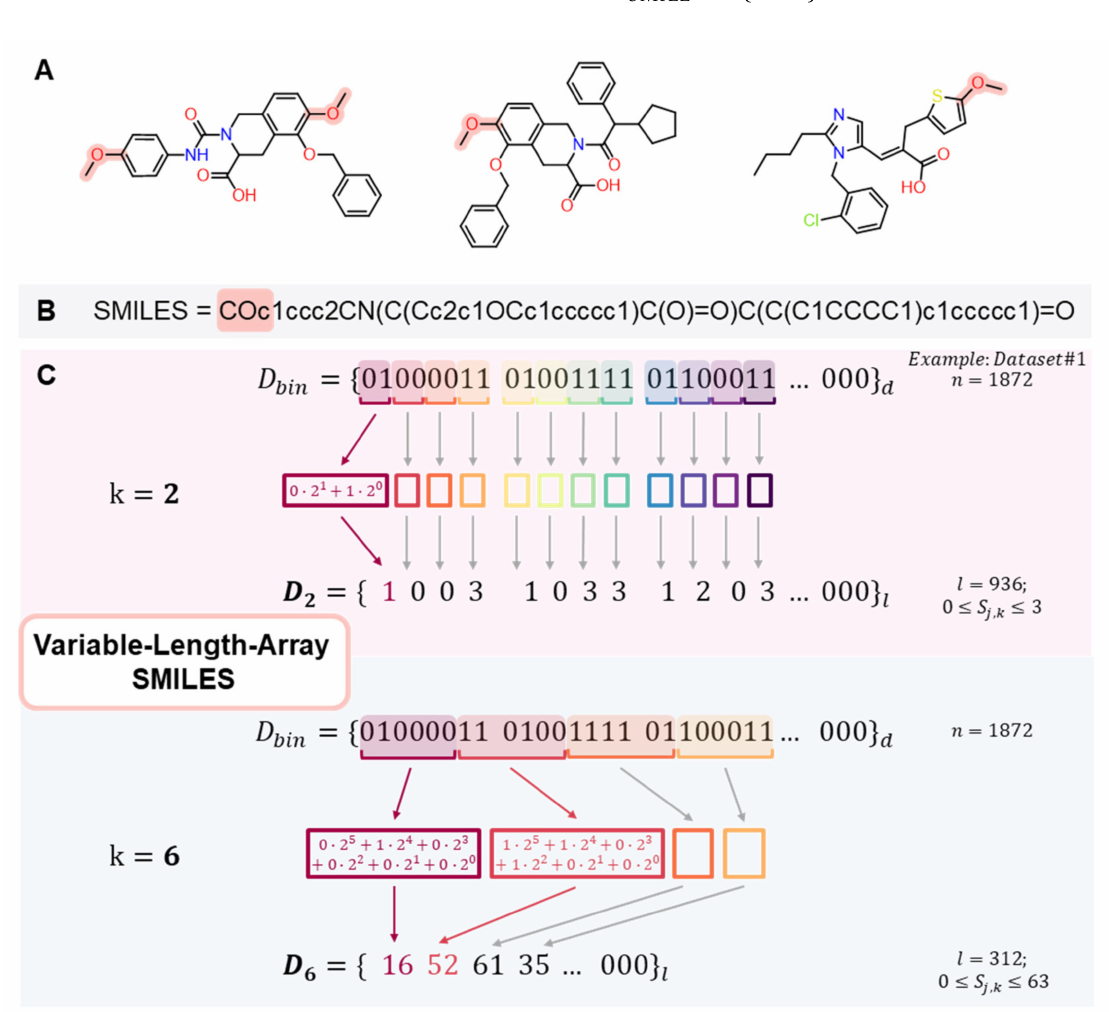
Figure 2. Data encoding using the variable-length-array-featured SMILES notation (VLA-SMILES). ( A ) Examples of compounds carrying a methoxy functional group, a common structural motif in the dataset. ( B ) SMILES representation of one example. The methoxy group and its SMILES code are highlighted in red. ( C ) Binary mapped SMILES representation with zero padding at the end of the sequence. Transformation of the obtained arrays D 2 ( k = 2) and D 6 ( k =